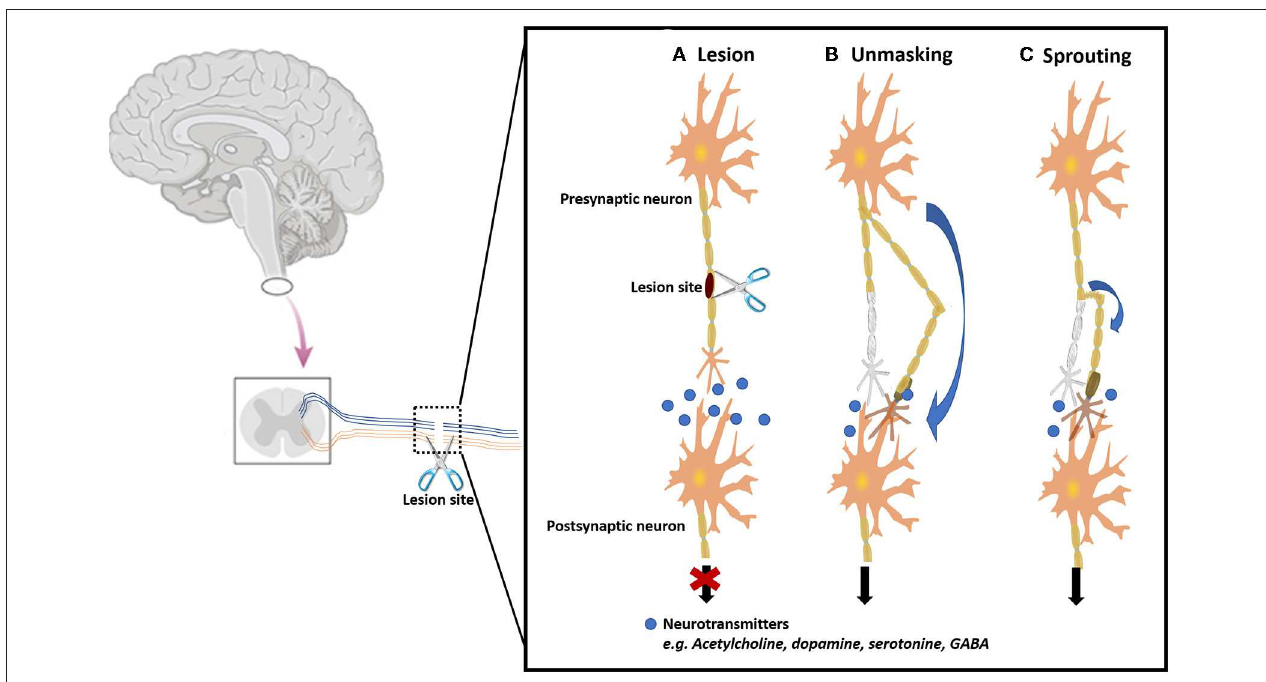
FIGURE 10 | Scheme representing the neuroplasticity that occurs throughout the CNS after PNIs. (A) Healthy peripheral nerve being subjected to an injury. Immediately after the trauma, the functionality of the nerve is affected, and the correct neurotransmission is interrupted. Neuroplasticity that occurs in the CNS following PNI is thought to occur through several mechanisms, with two of the most prominent theories being: (B) Unmasking of existing synaptic connections. In this process, there is the unmasking of neural paths which were not normally used for a specific purpose, and new neural paths are activated when the normally used system fails; and (C) Sprouting of new nerve terminals, where there is collateral sprouting from intact healthy cellular components to a denervated region, in an attempt to reestablish the neuronal